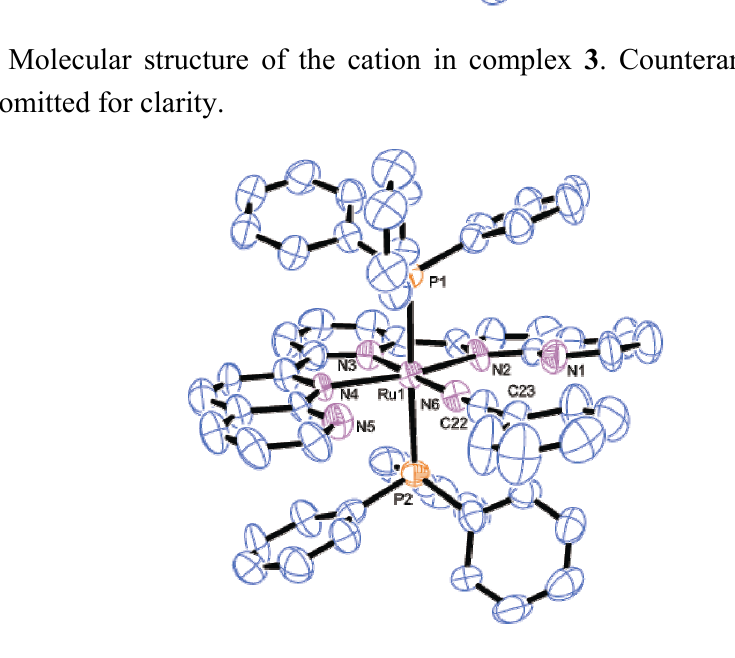
Figure 5. Molecular structure of the cation in complex 8 . The counteranion, solvent molecules, and hydrogen atoms are omitted for